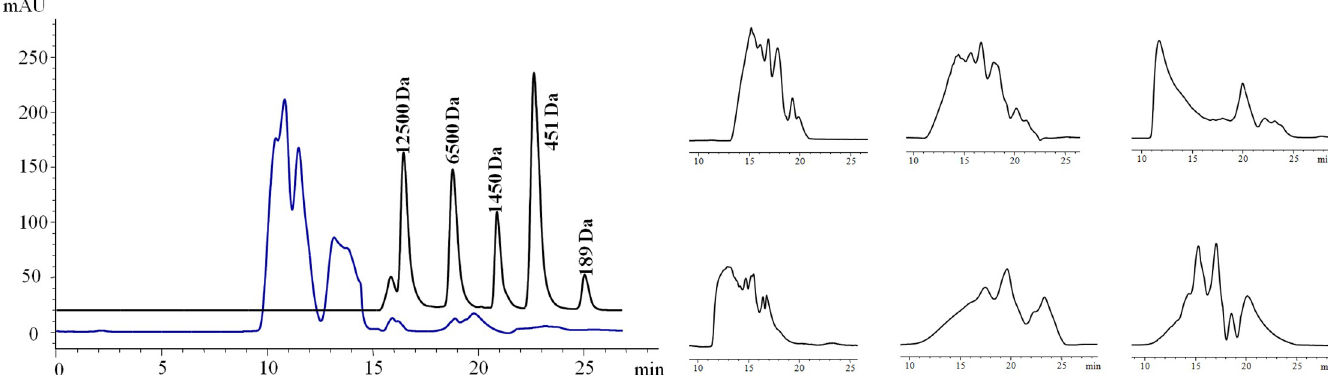
Fig 7. Peptide profile of soybean protein isolates hydrolyzed by HypZn or five commonly used commercial proteases. A: Peptide profile of soybean protein isolate substrate (unhydrolyzed); B: Soybean protein isolate hydrolysates treated with HypZn; C: Soybean protein isolate hydrolysates treated with trypsin; D: Soybean protein isolate hydrolysates treated with papain; E: Soybean protein isolate hydrolysates treated with acid protease; F: Soybean protein isolate hydrolysates treated with pepsin; G: Soybean protein isolate hydrolysates treated with alkaline protease.